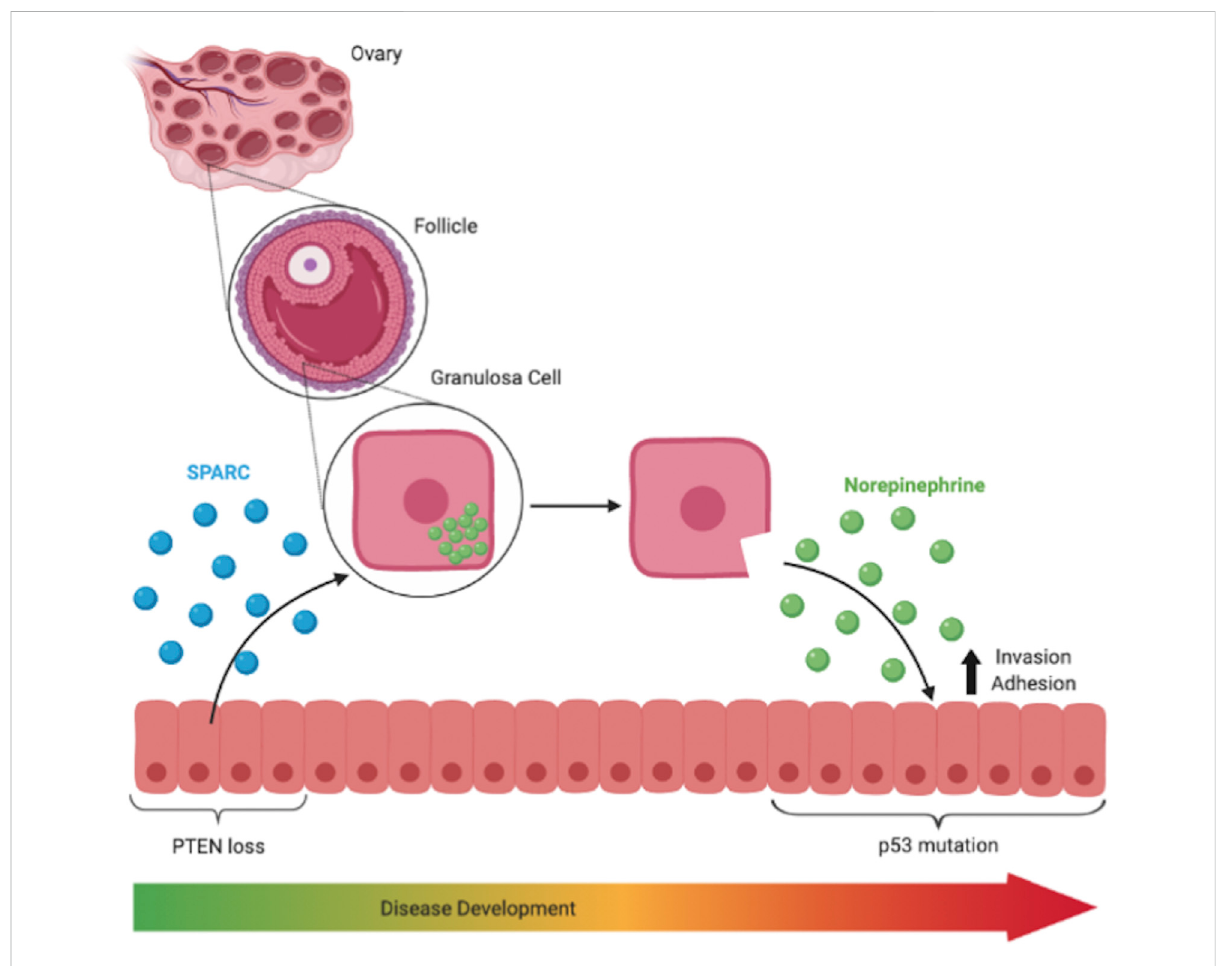
FIGURE 6 SPARC is known to upregulate production of enzymes that remodel the basement membrane in follicles and is responsible for the release of ovarian NE into the surrounding environment. NE treatment increased invasiveness and adhesive capabilities of p53 mutated cells.